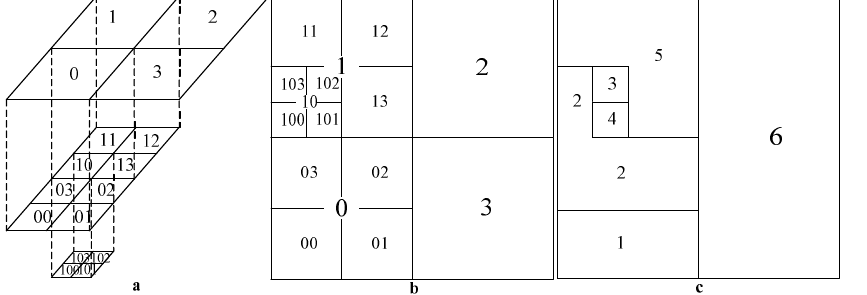
Figure 6. Hilbert curve hierarchy principle. ( a ) Three dimensional representation of spatial region divided by Hilbert curve, ( b ) Two dimensional representation of spatial region divided by Hilbert curve, ( c ) Two dimensional representation of merged spatial regions.